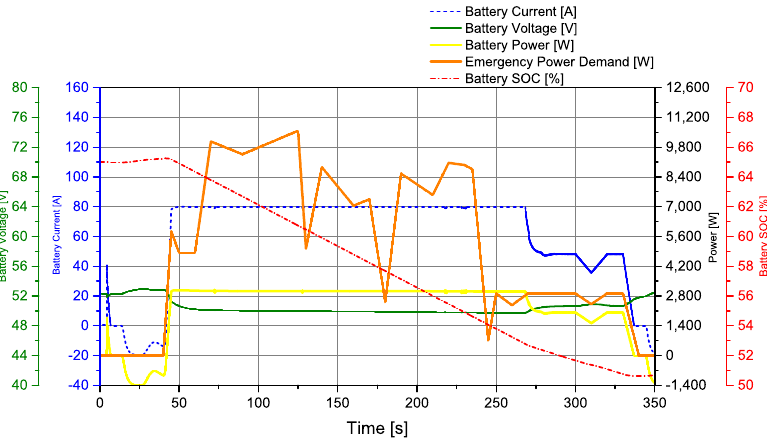
Figure 13. Battery’s current, voltage, and SOC variations during simulation.